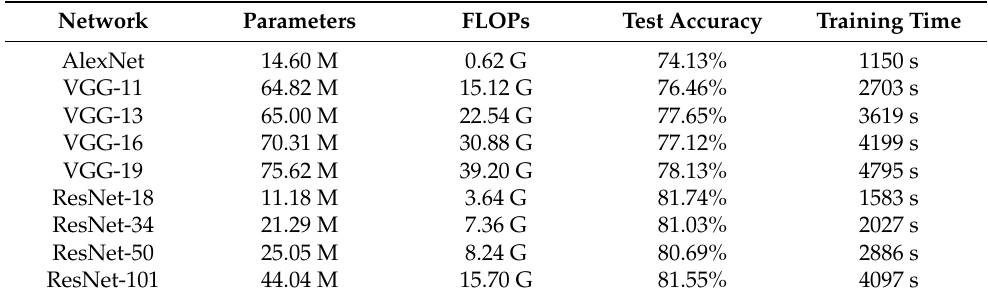
Table 2. Performance summary of several classical networks on sonar image datasets.